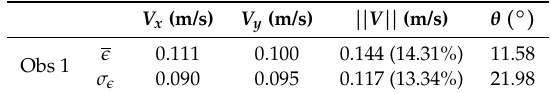
Table 5. Real scenario 4—Errors in velocities